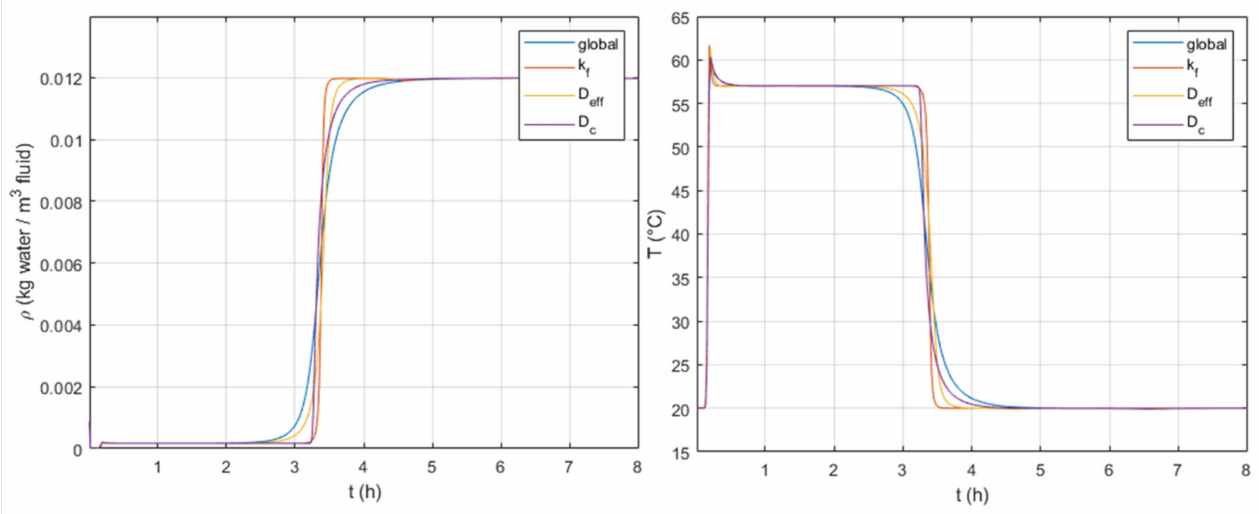
· a s . Effect of different mass transfer resistances on the breakthrough i